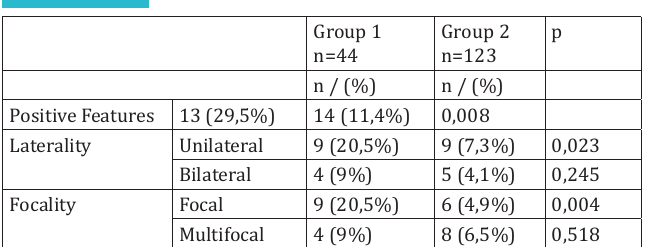
Imaging findings of the patients